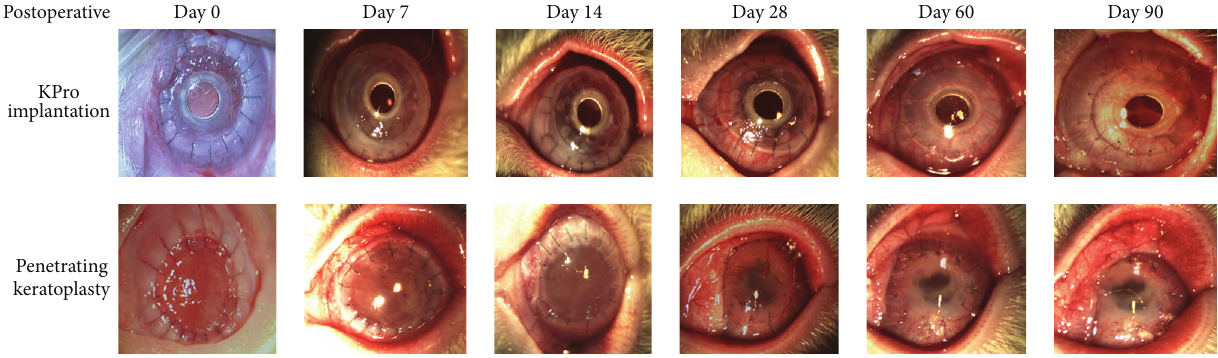
Figure 2: Clinical observation of alkali-burned rabbit corneas following Boston Type 1 keratoprosthesis (KPro) implantation or penetrating keratoplasty. Photographs taken immediately after operation and at postoperative days 7, 14, 28, 60, and